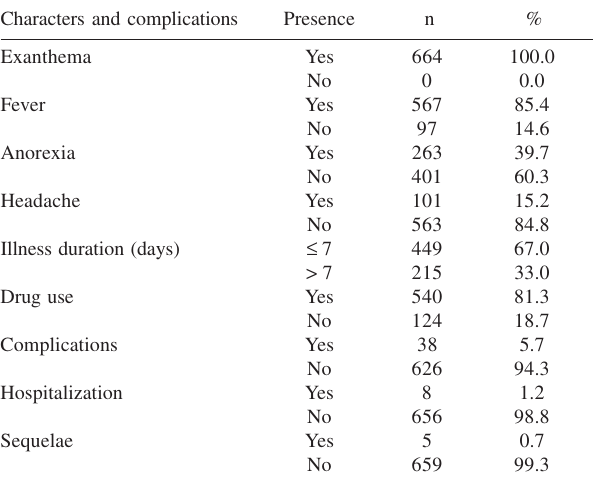
Table 3 - Morbidity associated with varicella Characters and complications